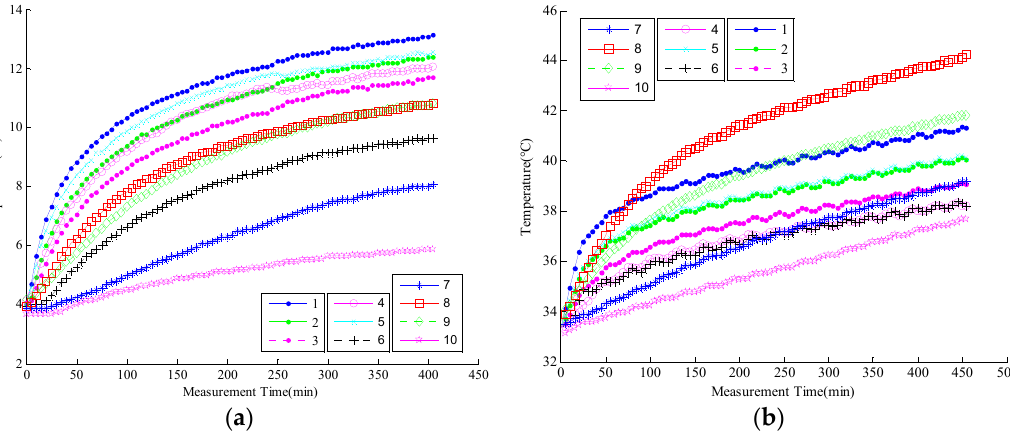
Figure 3. ( a ) Temperature change curves of experimental batches K1; ( b ) temperature change curves of experimental batches K46.